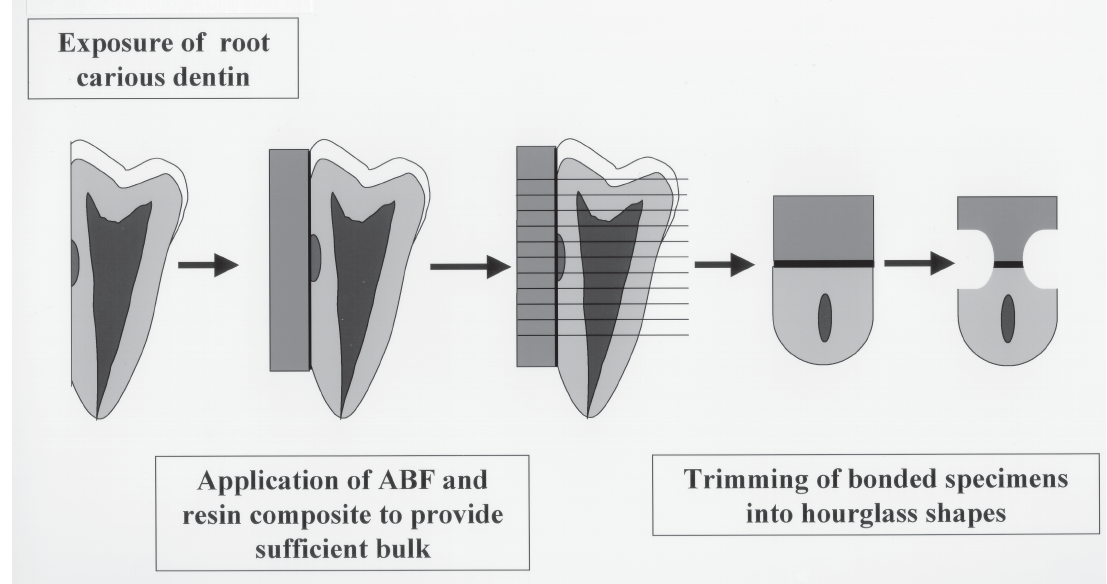
FIGURE 7 -Schematic diagram showing the methodology used in our study to measure µ TBS of ABF to root carious dentin